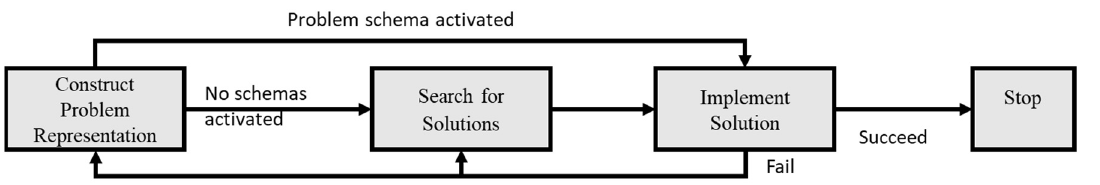
Figure 1. Problem-Solving Model (Gick, 1986).